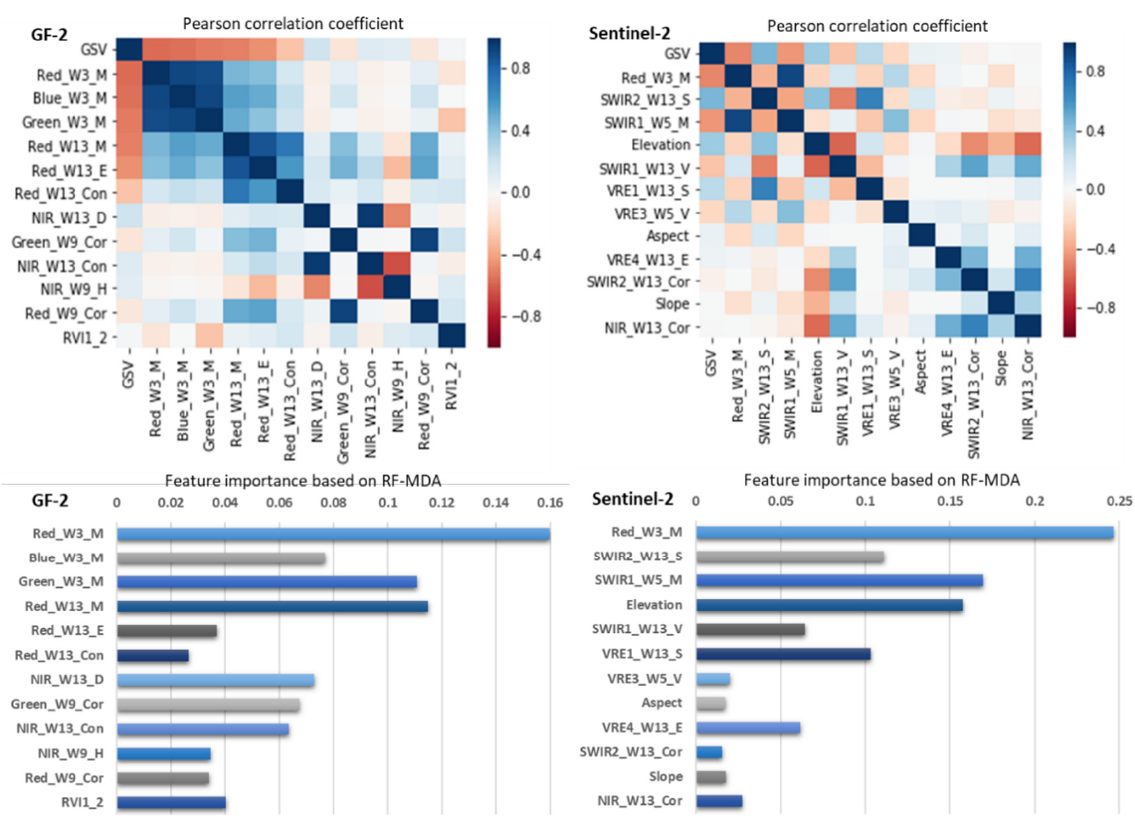
Figure 5. The correlation and importance analysis of the feature variables selected by AFCO-RFR method based on the GF-2 and Sentinel-2 datasets, respectively.